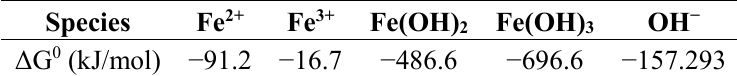
Table 1. Standard Gibbs free energies of species at 25 °C [14].